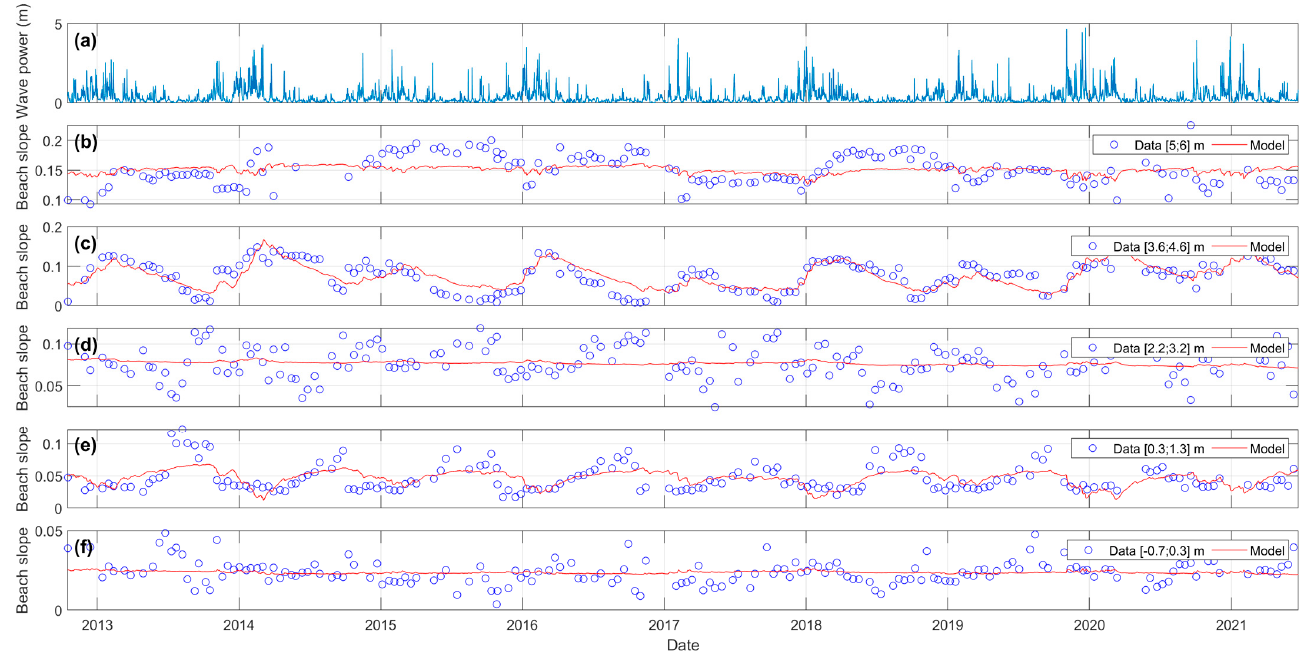
Figure 6. Time series of ( a ) wave power and ( b – f ) observed (circles) and modeled (solid line) beach slope between ( b ) 5–6 m; ( c ) 3.6–4.6 m; ( d ) 2.2–3.2 m ( e ) 0.3–1.3 m and ( f ) − 0.7–0.3